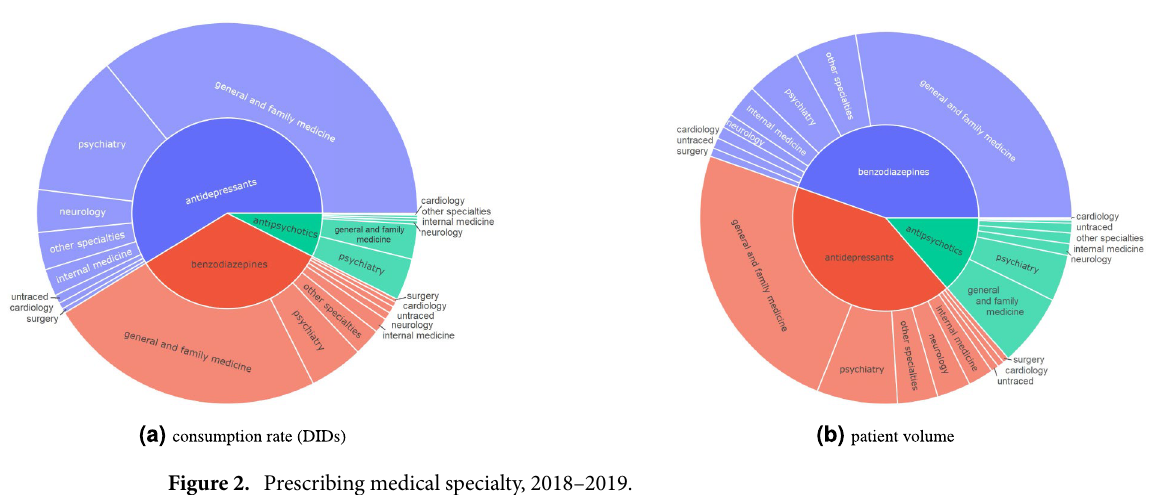
Figure 2. Prescribing medical specialty,